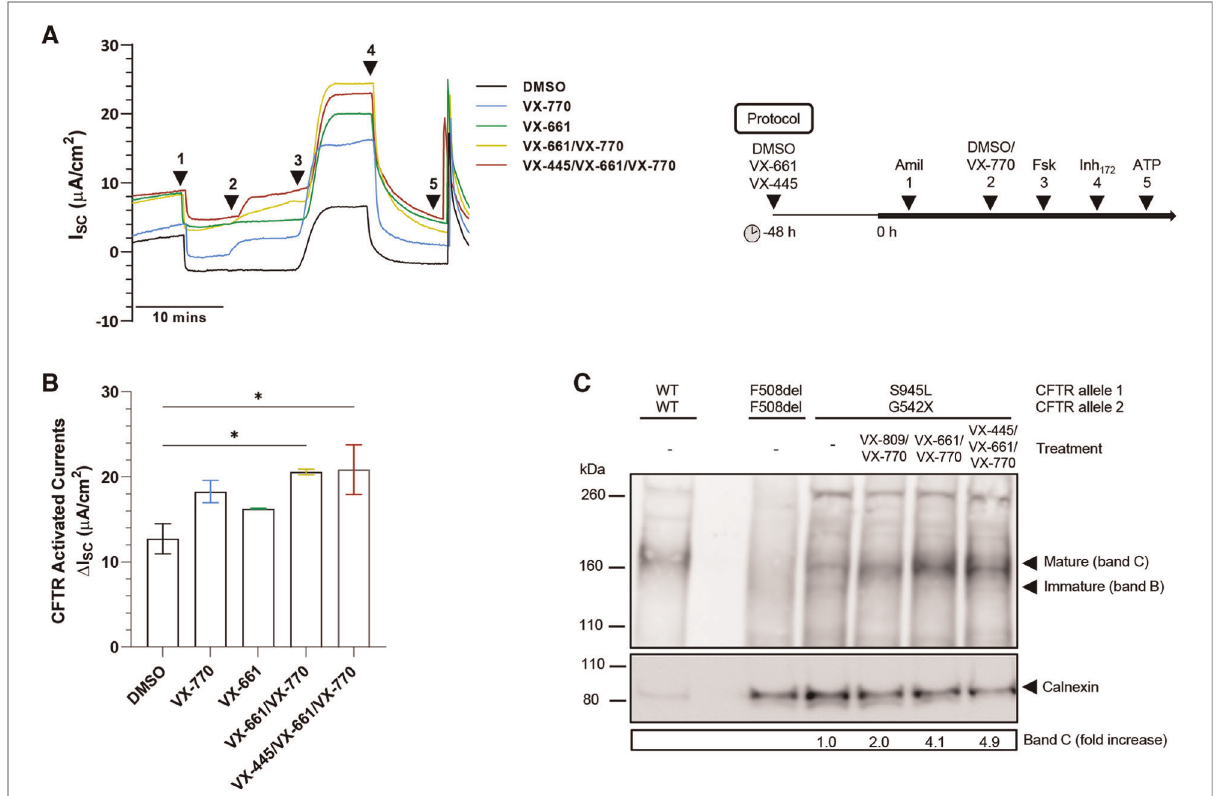
FIGURE 2 Effect of TEZ/IVA in vitro in S945L/G542X-CFTR patient-derived human nasal epithelial cell (hNEC) air-liquid interface (ALI) cultures. ( A ) Representative Ussing chamber recordings of short circuit current ( I SC ) in hNECs from a S945L/G542X participant. The protocol used to measure functional CFTR expression in hNECs pre-treated at 48 h with corrector (5 μ M VX-661 or 3 μ M VX-445/18 μ M VX-661) or vehicle (0.01% DMSO), followed by sequential addition from 0 h with 100 μ M apical amiloride (1. Amil), apical 0.01% DMSO or 10 μ M VX-770 (2. DMSO, VX-770), 10 μ M basal forskolin (3. Fsk), 30 μ M apical CFTR-speci fi c inhibitor (4. CFTR Inh − 172 ) and 100 μ M apical ATP (5. ATP). A basolateral-to-apical chloride gradient was used. ( B ) Bar graphs of total mean CFTR activated currents stimulated by DMSO or VX-770 plus Fsk in hNECs untreated or pre- treated with VX-661 or VX-445/VX-661. Data are from 2 to 3 independent ALI cultures and are represented as Mean±SEM. Ordinary one-way ANOVA was used to determine statistical signi fi cance. * p <0.05. ( C ) Western blot in cell lysates from S945L/G542X differentiated nasal epithelial cells. Cell lysates of F508del/F508del and WT/WT hNECs were used as controls to indicate protein size of CFTR bands B and C. To avoid signal saturation, the WT/WT sample was loaded at 7% of the mutant CFTR samples. S945L/G542X CFTR maturation following treatment with LUM/IVA (VX-809/VX-770), TEZ/IVA (VX-661/VX-770) or ELX/TEZ/IVA (VX-445/VX-661/VX-770) was quanti fi ed by measuring the level of mature CFTR (band C) in treated cells as a fold increase compared to mature CFTR in untreated cells. Band C represents the mature, complex-glycosylated CFTR. Band B represents the immature, core-glycosylated CFTR. All data were normalized to the calnexin loading control.